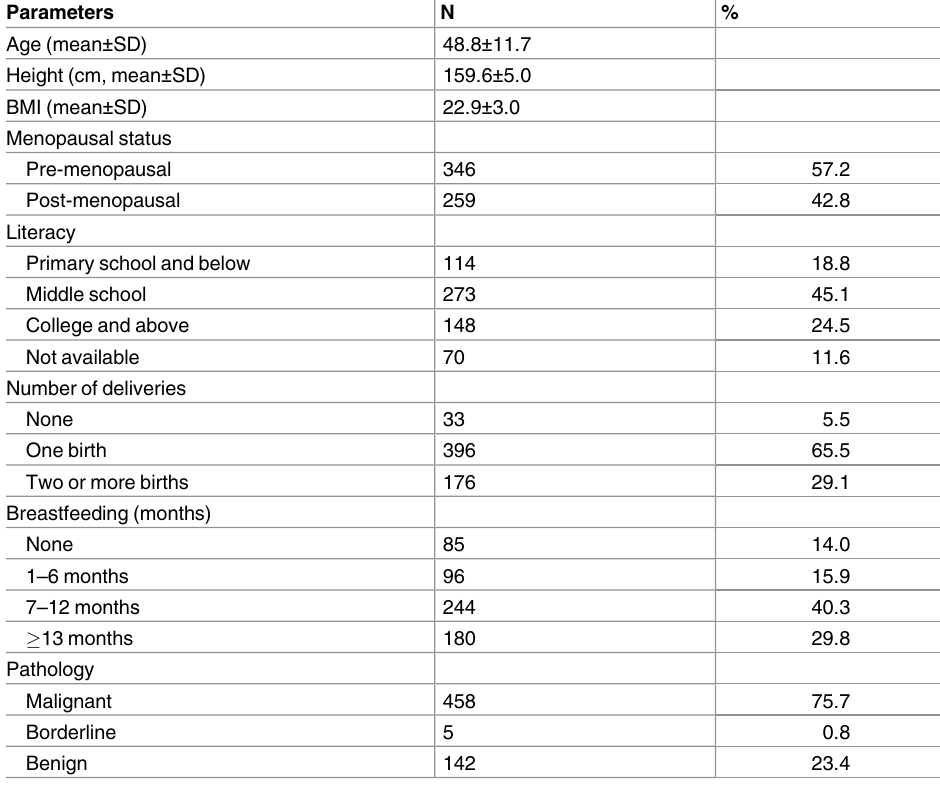
Table 1. Baseline characteristics of all